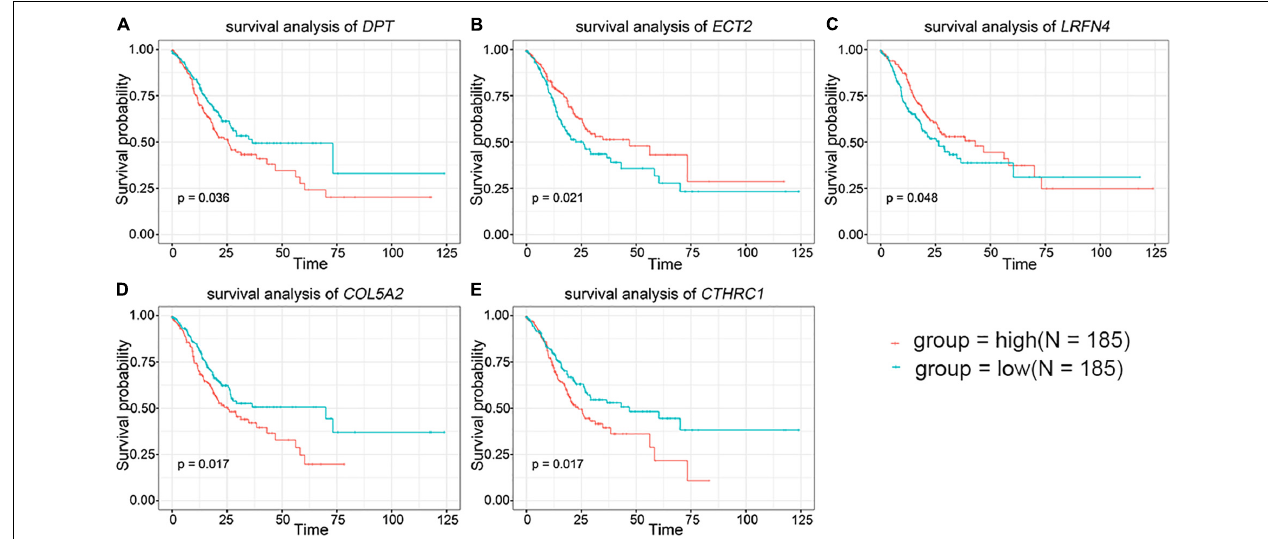
FIGURE 2 | The prognostic value of key genes in the overall survival of stomach adenocarcinoma (STAD) patients. (A) DPT. (B) ECT2 . (C) LRFN4 . (D) COL5A2 . (E) CTHRC1 . The red lines signified individuals with high expression of gene and blue lines denoted those with low expression.